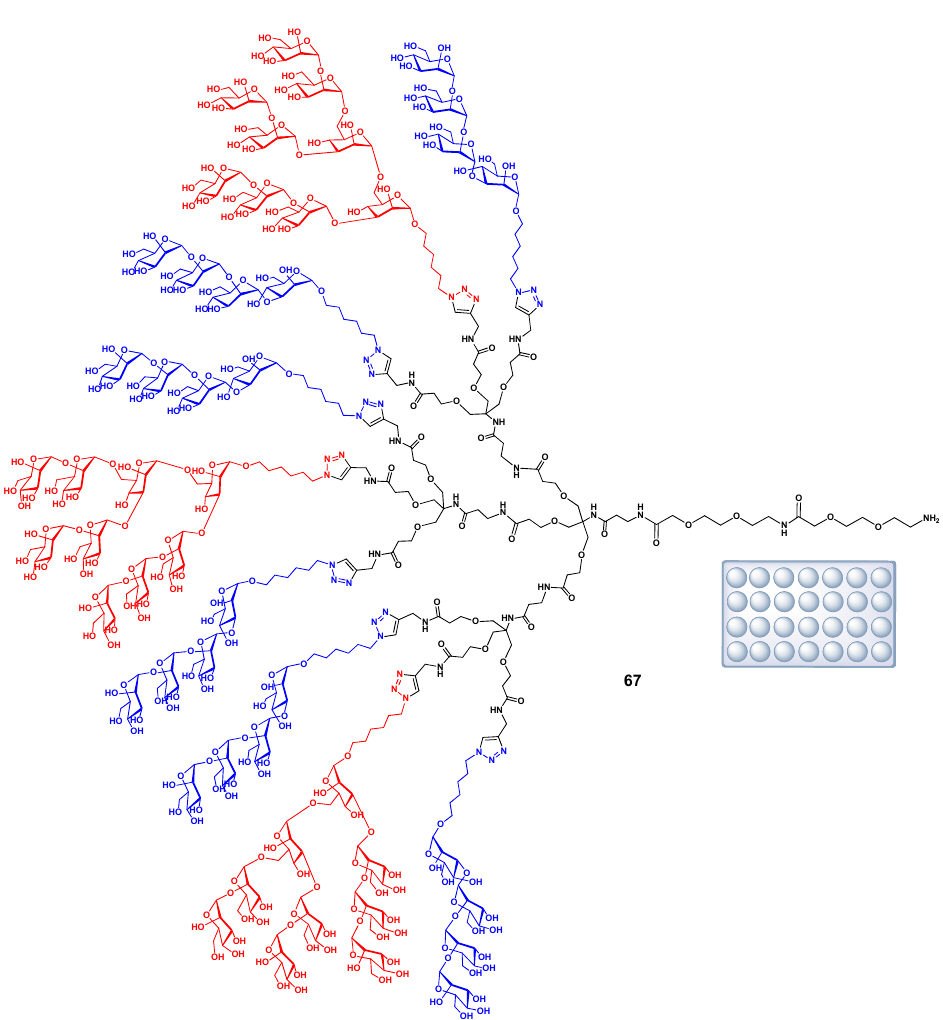
Figure 4. Representative oligomannose dendron constructs. The ratio of Man 4 /Man 9 is 5:4. Man 4 is marked in blue and Man 9 is marked in red [59].